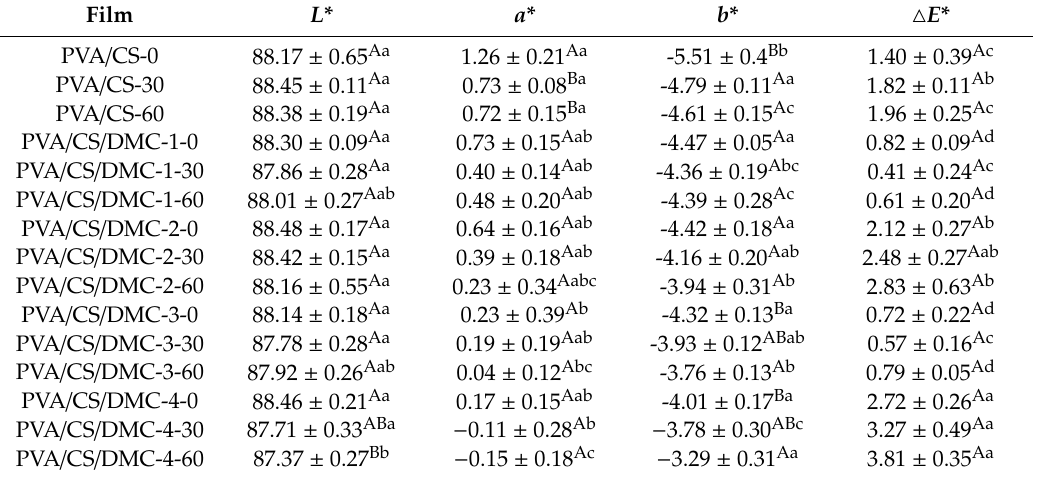
Table 2. Color properties of di ff erent composite films in the case of varying ultrasonication